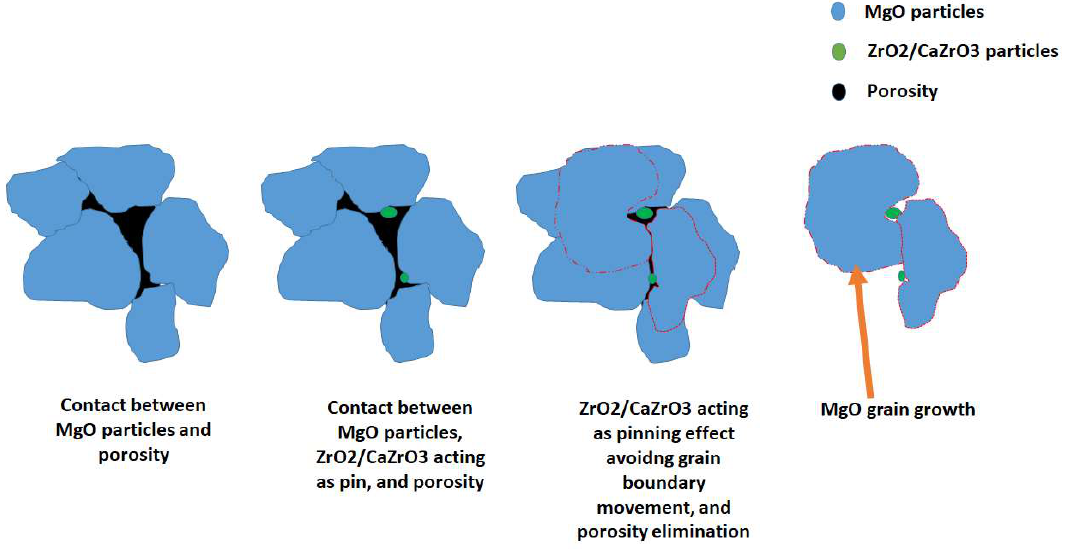
Figure 4. Influence of ZrO 2 nanoparticles on the densification of the samples.